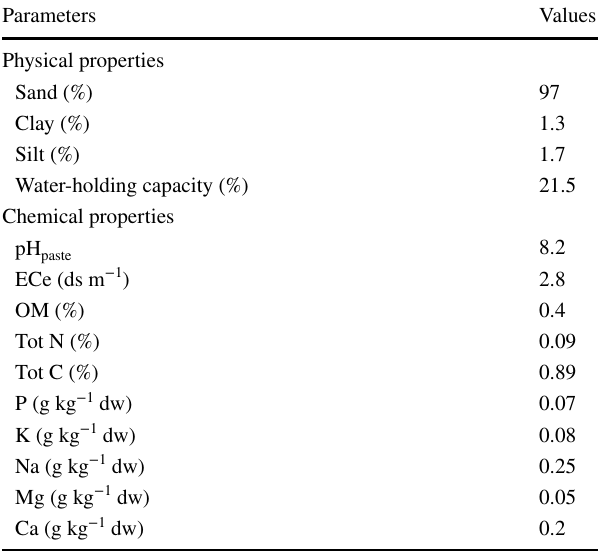
Table 1 Physical and chemical properties of the soil used in the